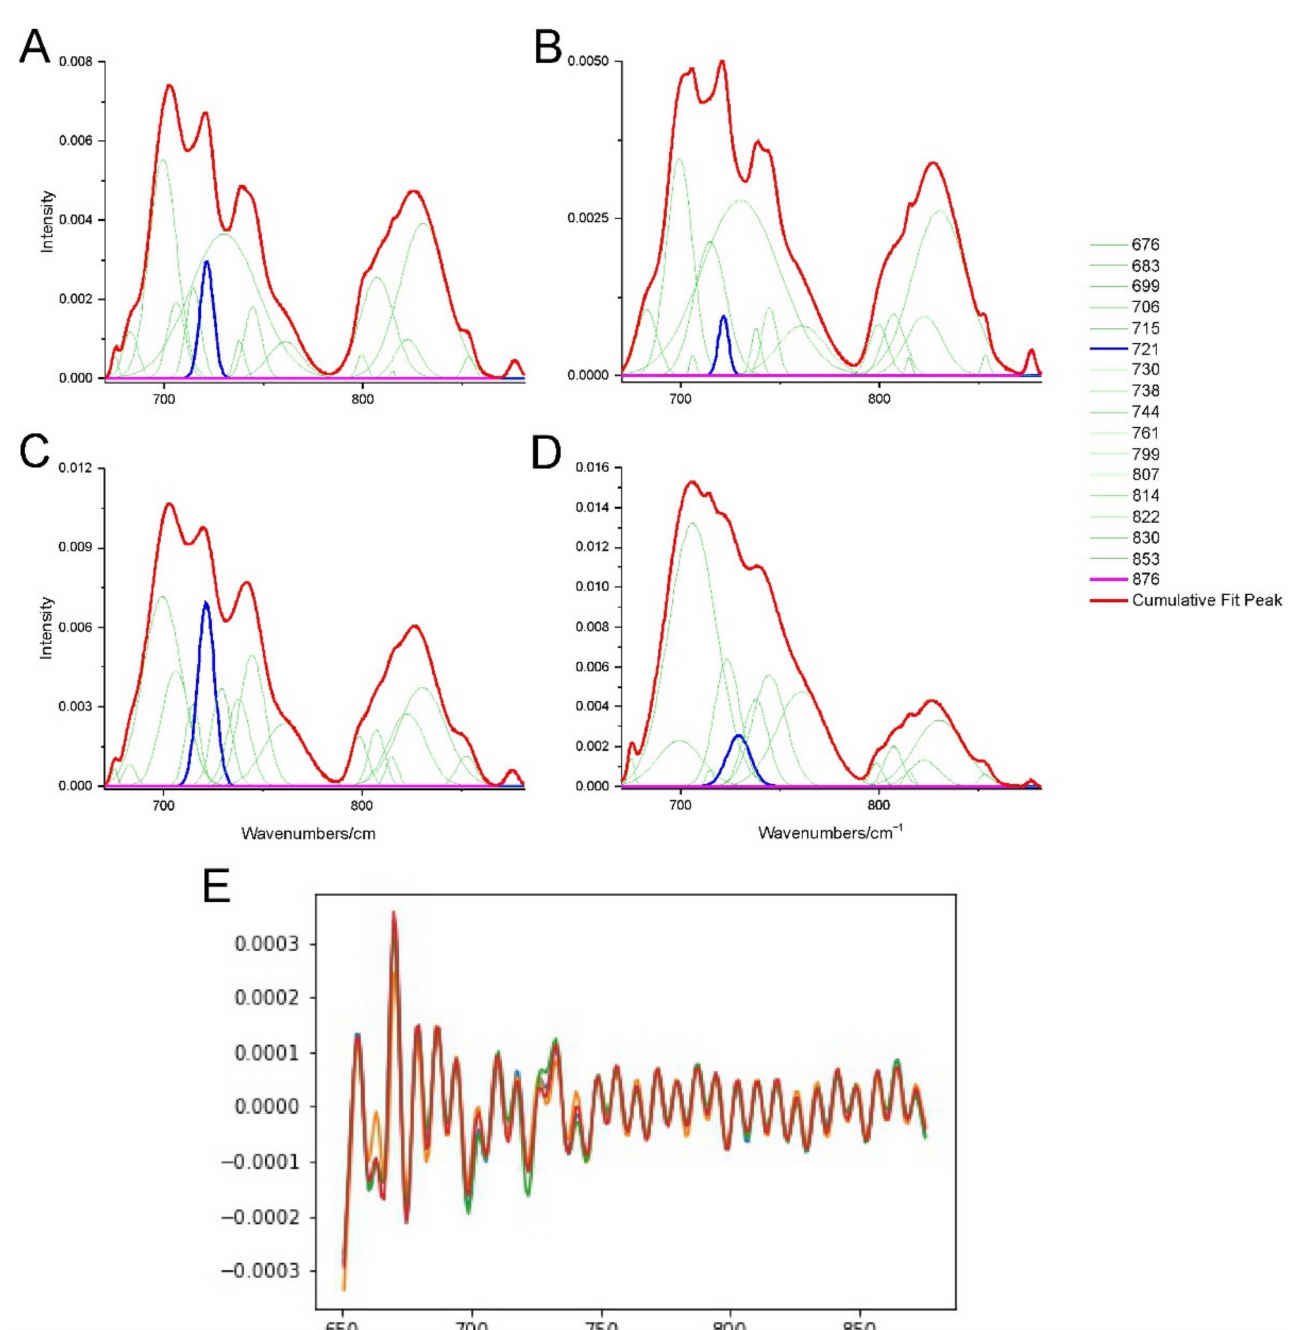
Figure 4. The deconvoluted and second derivative spectra of the oxidative stress region (region C) in the 882–670 cm − 1 : ( A ) hippocampus spectra of the control sample. ( B ) hippocampus spectra of the TP-315 treated sample. ( C ) cerebral cortex spectra of the control sample. ( D ) cerebral cortex spectra of the TP-315 treated sample. The interesting bands are marked with blue and pink color. ( E ) second derivative spectra of control mouse hippocampus (orange spectrum), hippocampus of the treated mouse (blue spectrum), cerebral cortex of the control mouse (red spectrum) and cerebral cortex of the treated mouse (green spectrum) The bands are described in Table